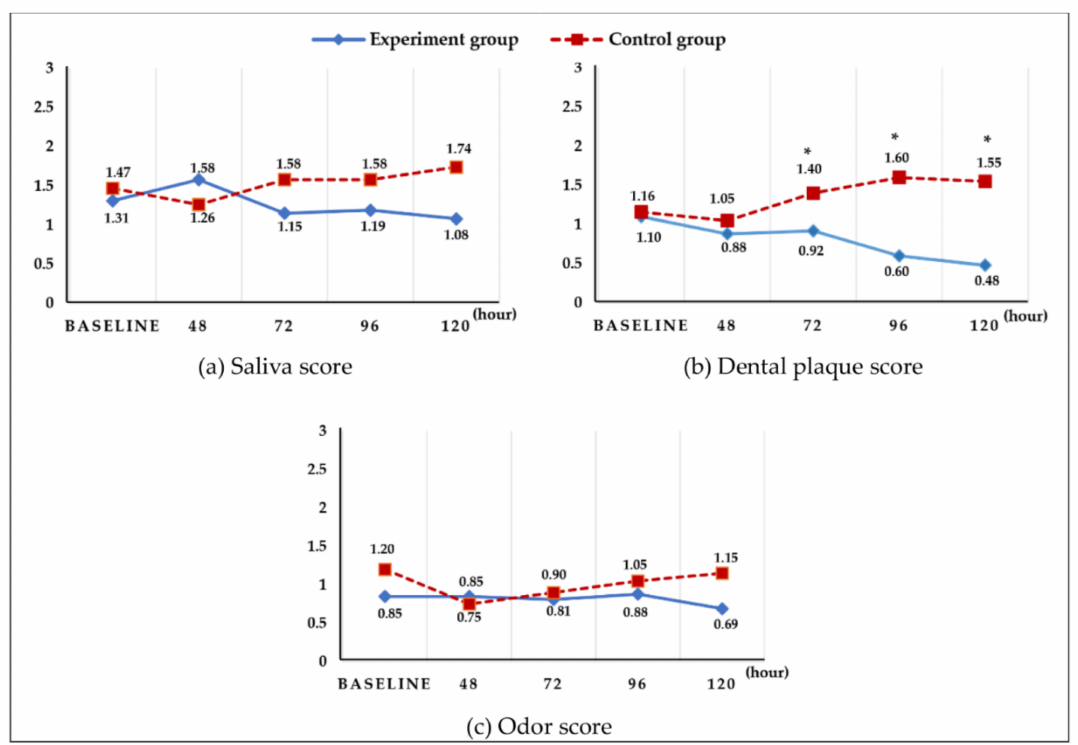
Figure 4. Changes in saliva, dental plaque, and odor score. There was no significant difference in saliva and odor, but the degree of dental plaque showed significant differences between groups at 72, 96, and 120 h hours (an independent t -test was conducted at each time point, Bonferroni correction * p <